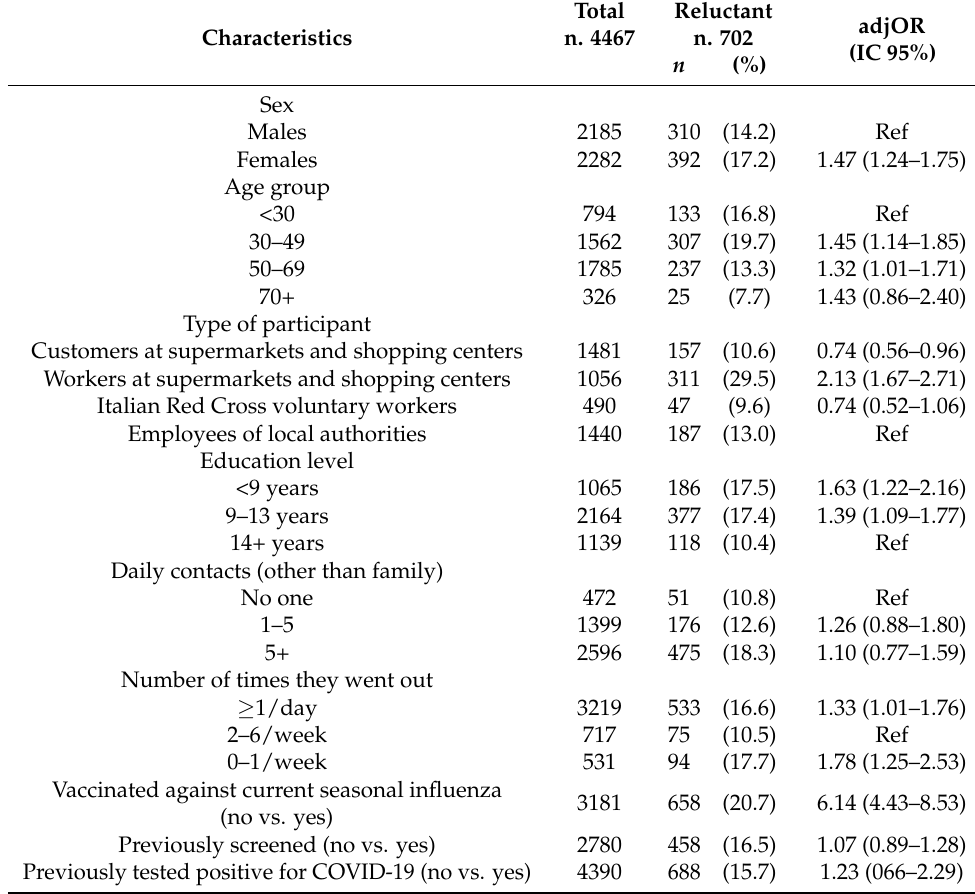
Table 2. Multivariable analysis (dependent variable: “Reluctant” to be vaccinated against COVID-19). Total Reluctant